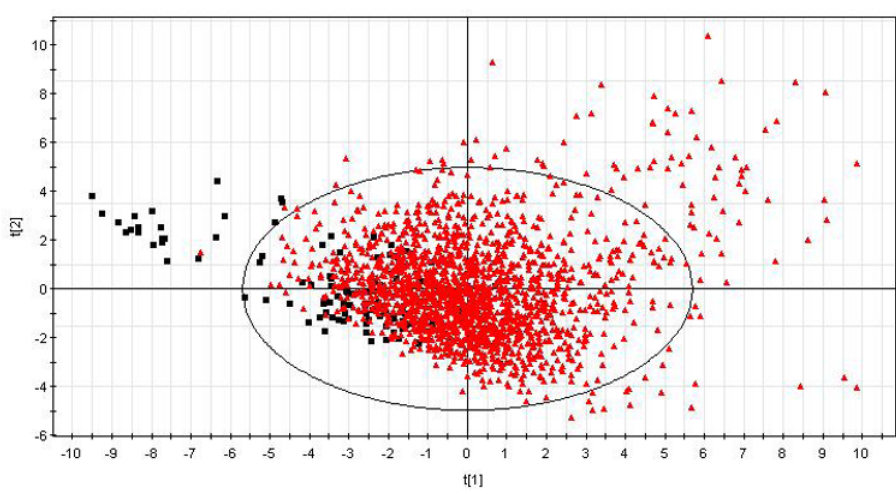
Figure 2. PCA score plots for the first two principal components t1,t2 - actives (black squares) and inactives (red triangles).